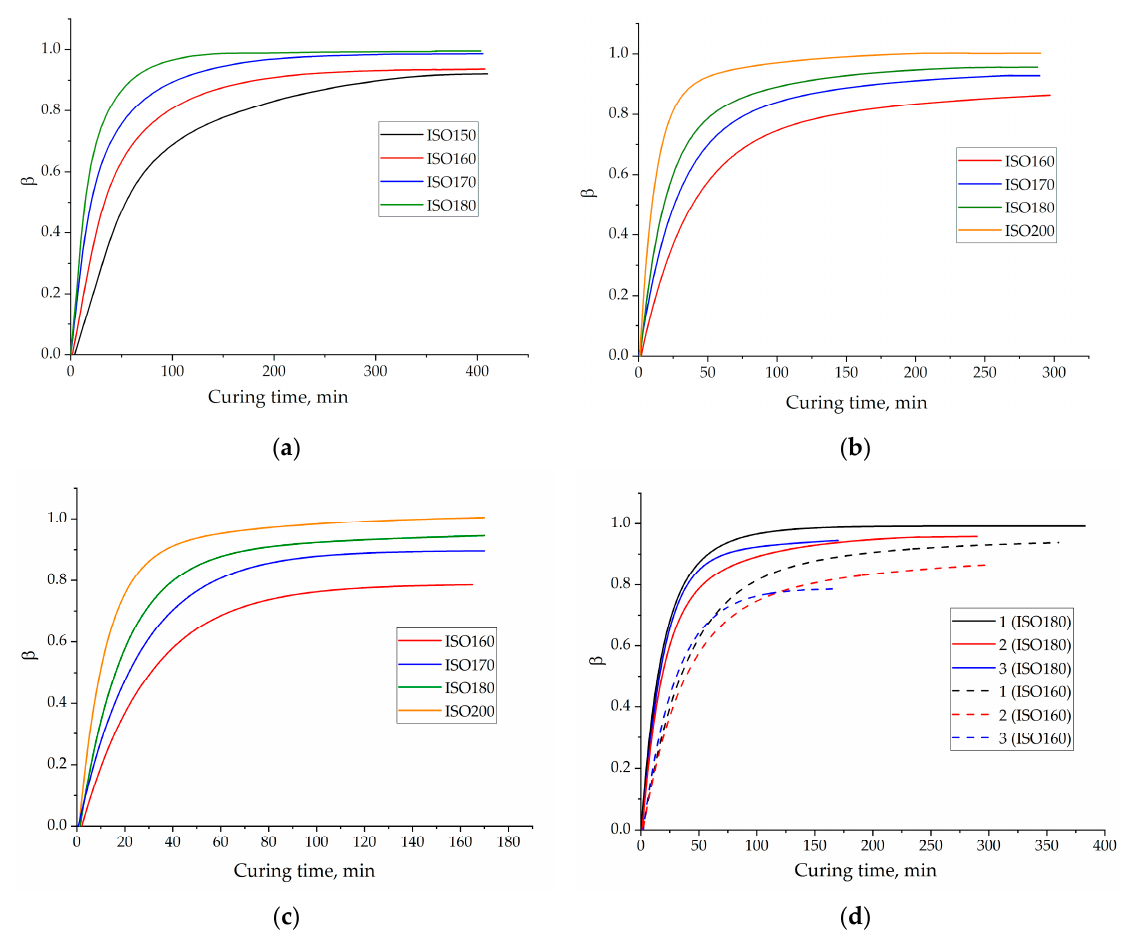
Figure 2. The dependences of the degree of conversion ( β ) on the curing time at isotherms: 150 (black), 160 (red), 170 (blue), 180 (green), 200 (orange) °C for formulation 1 ( a ), 2 ( b ), 3 ( c ). A comparison ( d ) of the β -dependencies for formulations 1 (black), 2 (red), 3 (blue) at isotherms 160 ° C (dash), 180 ° C (strait). Table 3. The values of R2 according to the 2-order equation for formulations 1–3.